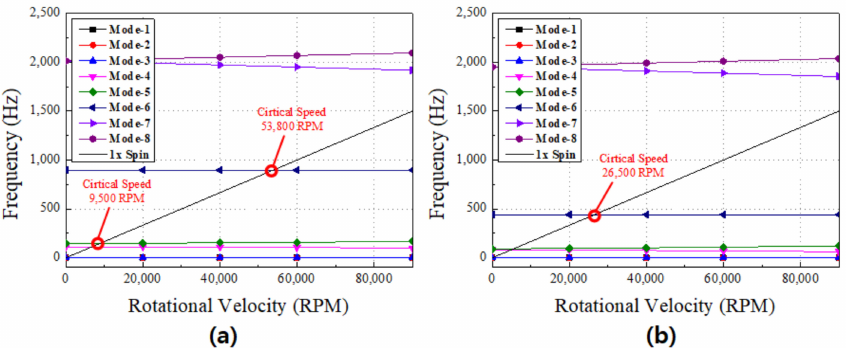
Figure 9. Critical speed analysis results of two different rotors ( a ) solid shaft, ( b ) hollow shaft.